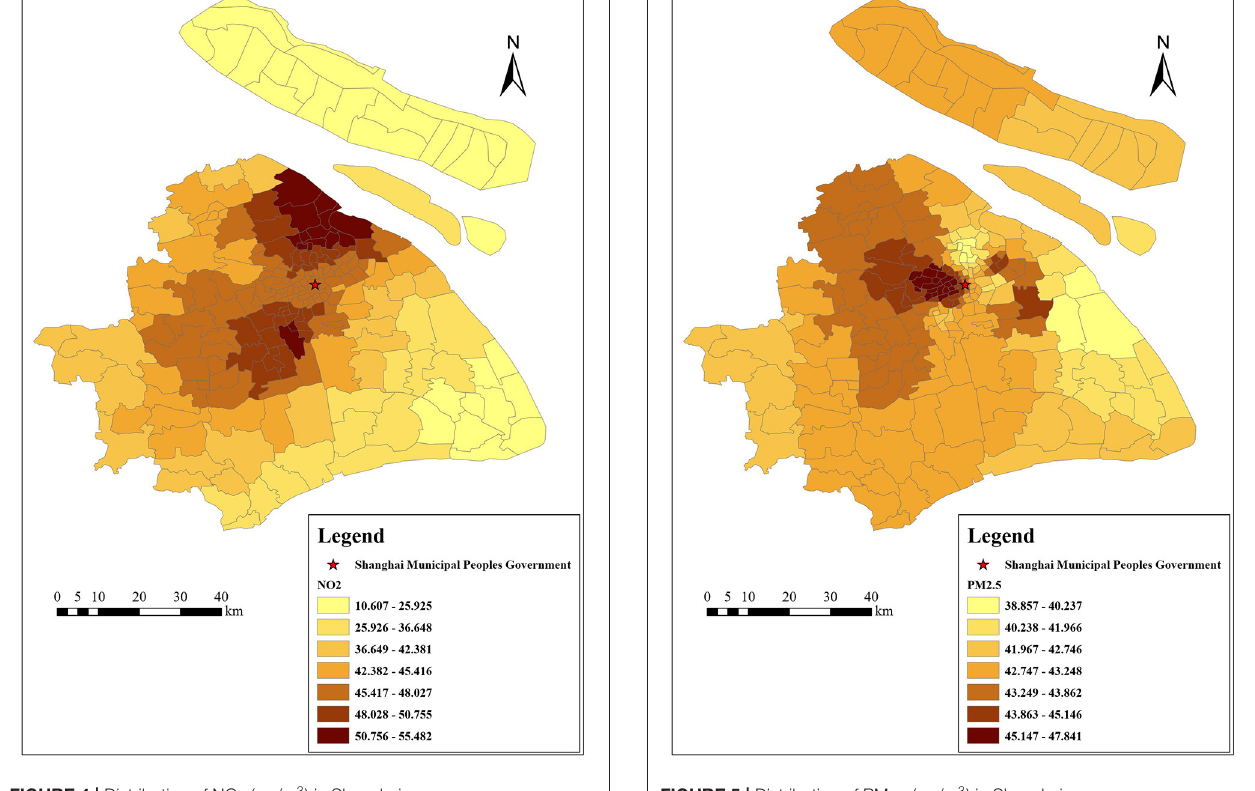
FIGURE 4 | Distribution of NO 2 ( µ g/m 3 ) in Shanghai. FIGURE 5 | Distribution of PM 2.5 ( µ g/m 3 ) in